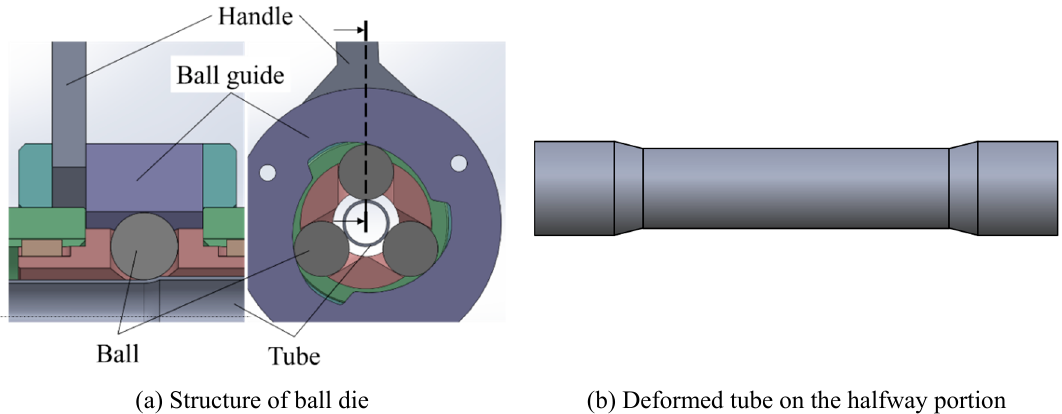
Figure 1. Schematics of ball die and deformed tube.